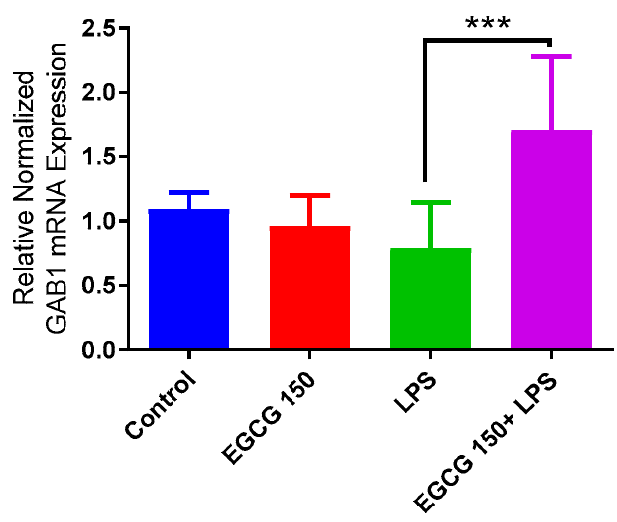
Figure 14. EGCG upregulated GAB1 . PCR array investigation indicated that EGCG 150 µM coupled with LPS (1 µg/mL) increased mRNA expression of GAB1 compared to LPS. Values represent the mean ± SD, *** p ≤ 0.001 vs. LPS. 3.6. EGCG Promotes Neuroprotection by Diminishing Protein Levels of NF- κ B2, AKT3, and mTOR